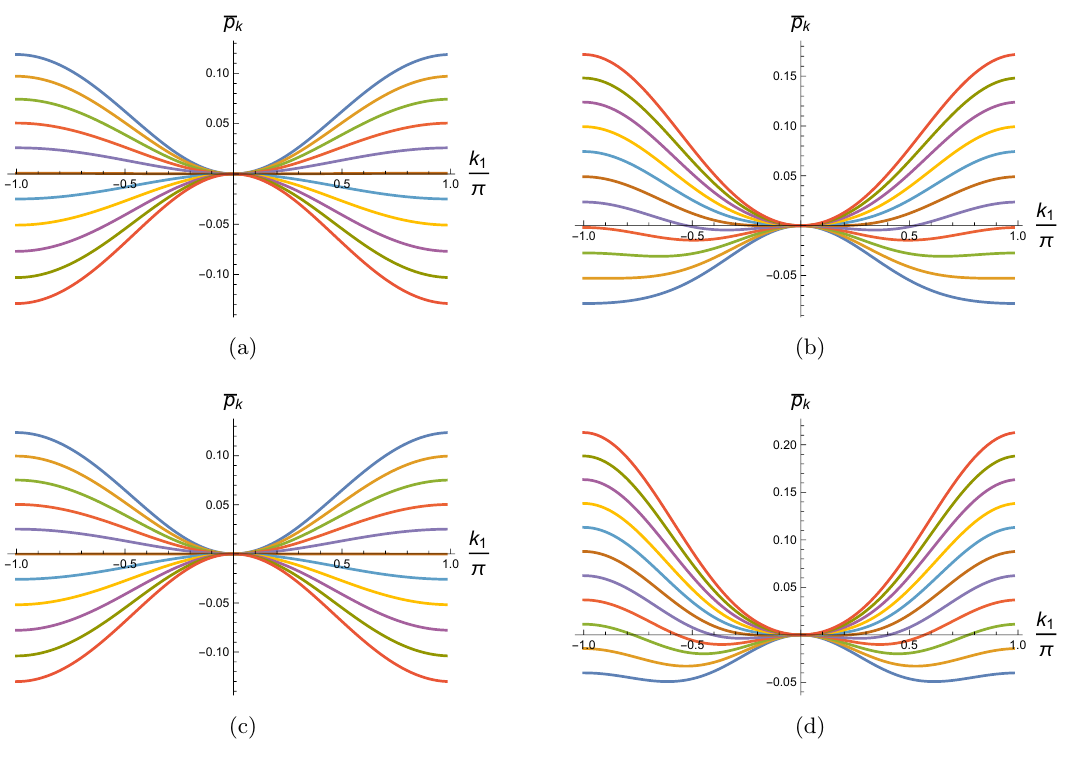
Figure 10 . (cid:22) p k ( (cid:28) ) plotted as a function of k = ( k 1 ; 0 ; 0) at di(cid:11)erent time slices. (a) From the top to bottom curves, (cid:28) changes from 0 : 815 to 1 : 315 in the step size of 0 : 05. At (cid:28) = (cid:28) (cid:3) (cid:25) 1 : 065, the 1 collective variable that describes the pattern of entanglement undergoes a global Lifshitz transition, where (cid:22) p k becomes (cid:13)at at all k . (b) From the bottom to top curves, (cid:28) changes from 3 : 35 to 3 : 85 in the step size of 0 : 05. At (cid:28) = (cid:28) (cid:3) (cid:25) 3 : 6, the collective variabl undergoes a local Lifshitz transition, where 2 the second derivative of (cid:22) p k vanishes at k = 0 while higher derivatives remain non-zero. (c) From the top to bottom curves, (cid:28) changes from 6 : 115 to 6 : 615 in the step size of 0 : 05. At (cid:28) = (cid:28) (cid:3) (cid:25) 6 : 365, 3 the collective variable undergoes the second global Lifshitz transition. (d) From the bottom to top curves, (cid:28) changes from 10 : 785 to 11 : 285 in the step size of 0 : 05. At (cid:28) = (cid:28) (cid:3) (cid:25) 11 : 035, the collective 4 variable undergoes the second local Lifshitz